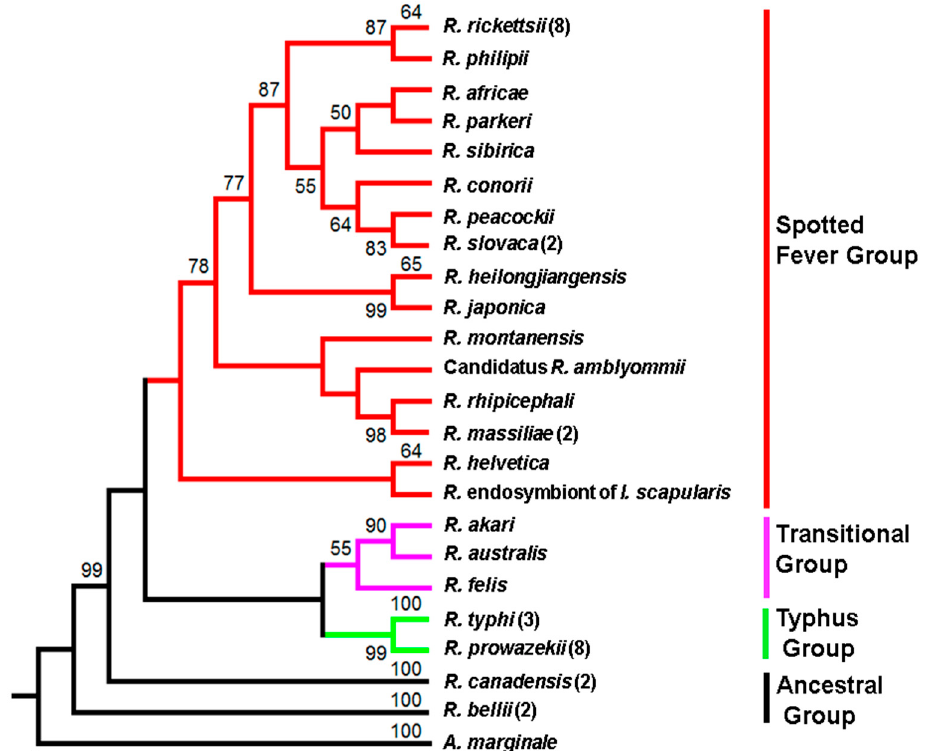
Figure 1. Phylogeny of Rickettsia species inferred from PleD protein sequences. The numbers above the branches indicate bootstrap support values. The PleD sequence of A. marginale str. Florida was used as an outgroup. The number in parenthesis indicates the number of strains used in the analysis. Branch color represents Rickettsia species belonging to different groups. Red: spotted fever group, Purple: Transitional group, Green: Typhus group, and Black: Ancestral group.